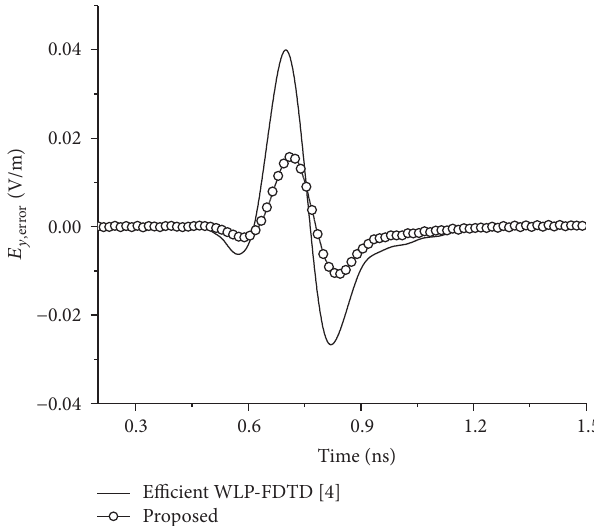
Figure 4: Error of 𝐸 𝑦 at 𝑝 ( 100Δ𝑥 , 65Δ𝑦 ). Calculated by the proposed method and the efficient WLP-FDTD